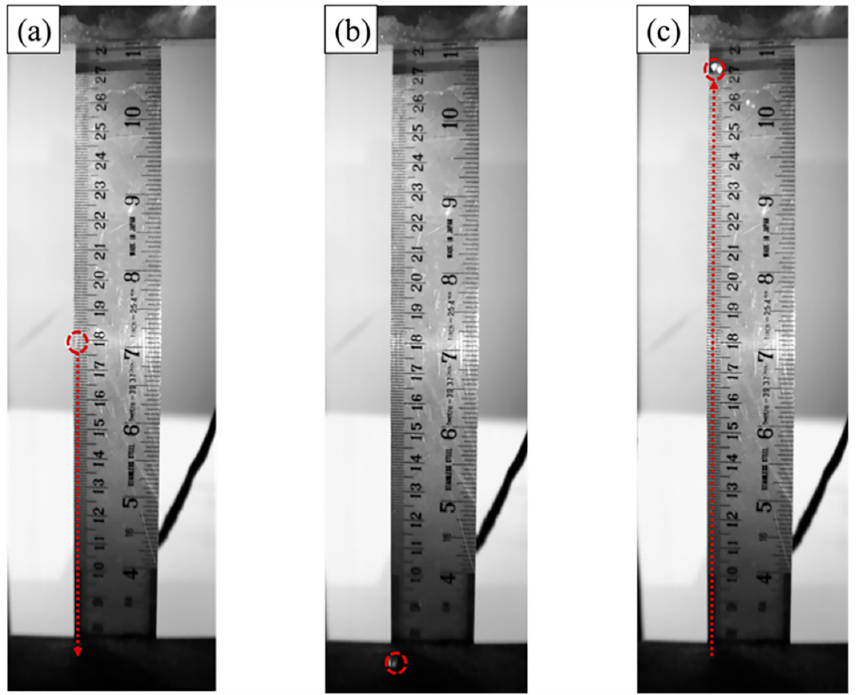
Figure 6. Various stages of 3 mm glass ball impacting on the granitic block: ( a ) initial path of drop; ( b ) the glass bead impacting with the block surface; ( c ) path of rebound and the highest position achieved.